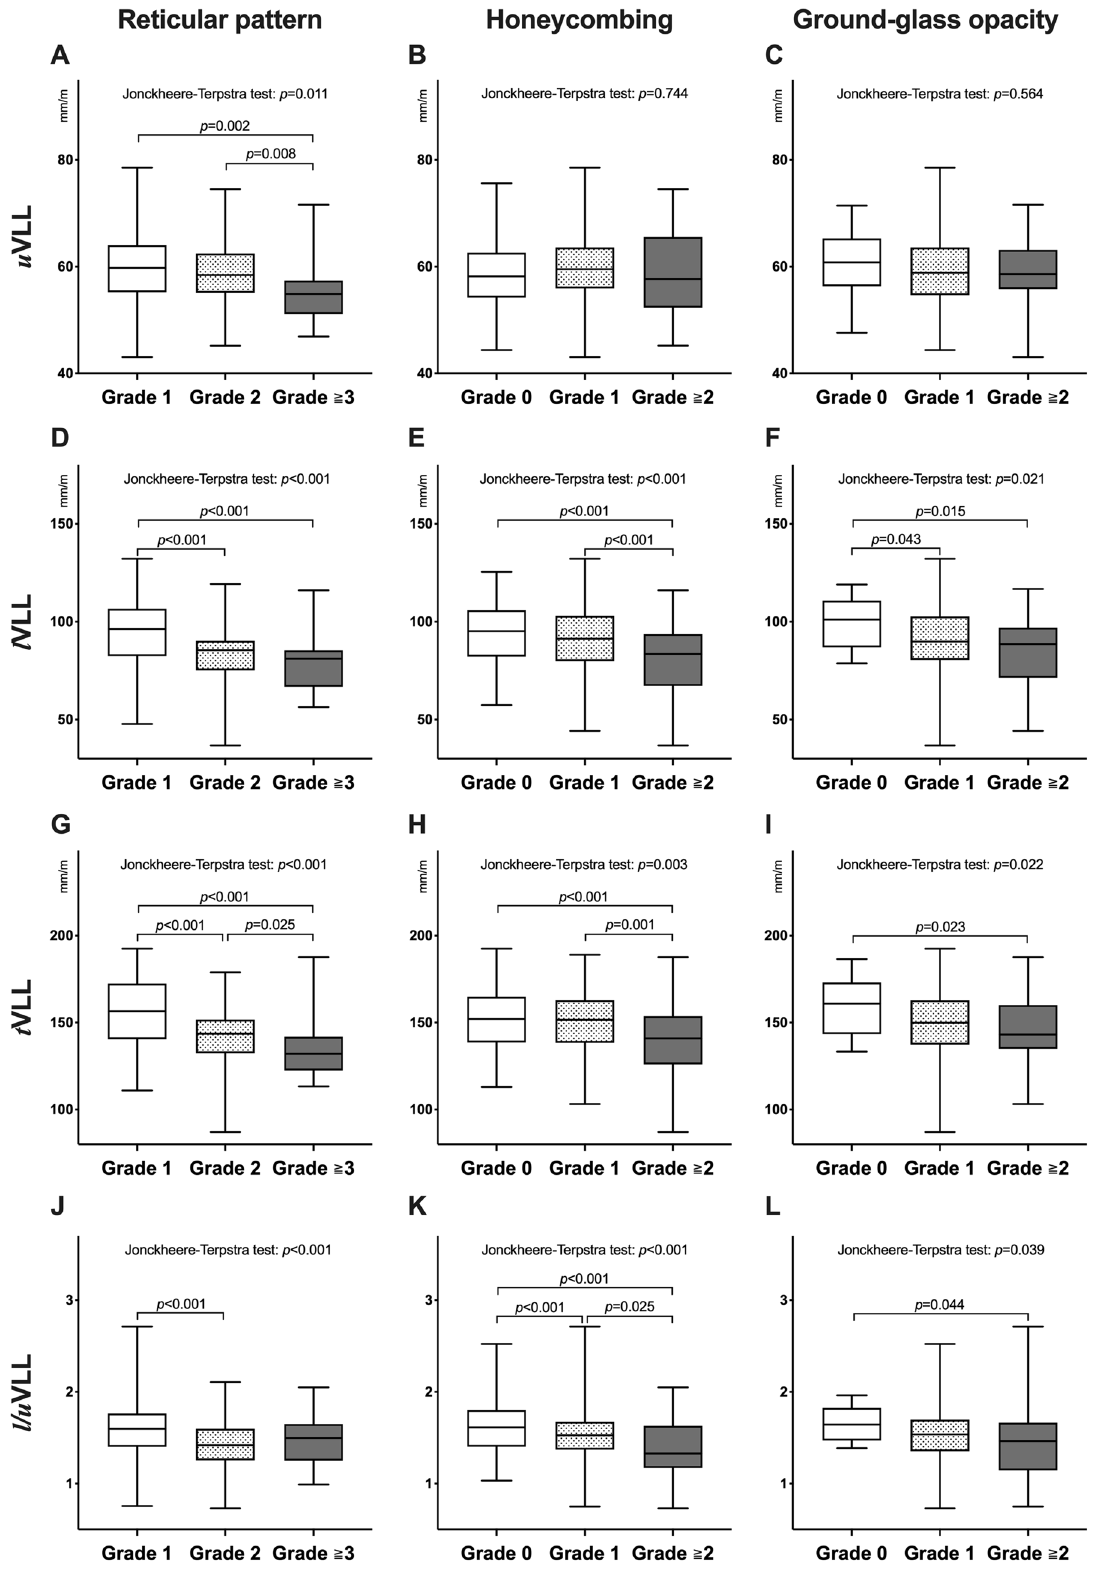
Figure 6. Associations of vertical lung lengths (VLLs) with the extent of lung abnormalities on chest CT images. The association of reticular pattern, honeycombing, and ground-glass opacity with upper VLL (uVLL) ( A – C ), lower VLL (lVLL) ( D – F ), total VLL (tVLL) ( G – I ), and l/uVLL ratio ( J – L ) are shown. The extents of the lung abnormalities were semi-quantitatively evaluated as follows: grade 0 (0%), grade 1 (< 25%), grade 2 (25–50%), grade 3 (50–75%), and grade 4 (> 75%). The white, grey, and black boxes in the images represent grade 1, 2, and ≥ 3 for reticular pattern, respectively, or grade 0, 1, and ≥ 2 for honeycombing and ground-glass opacity,